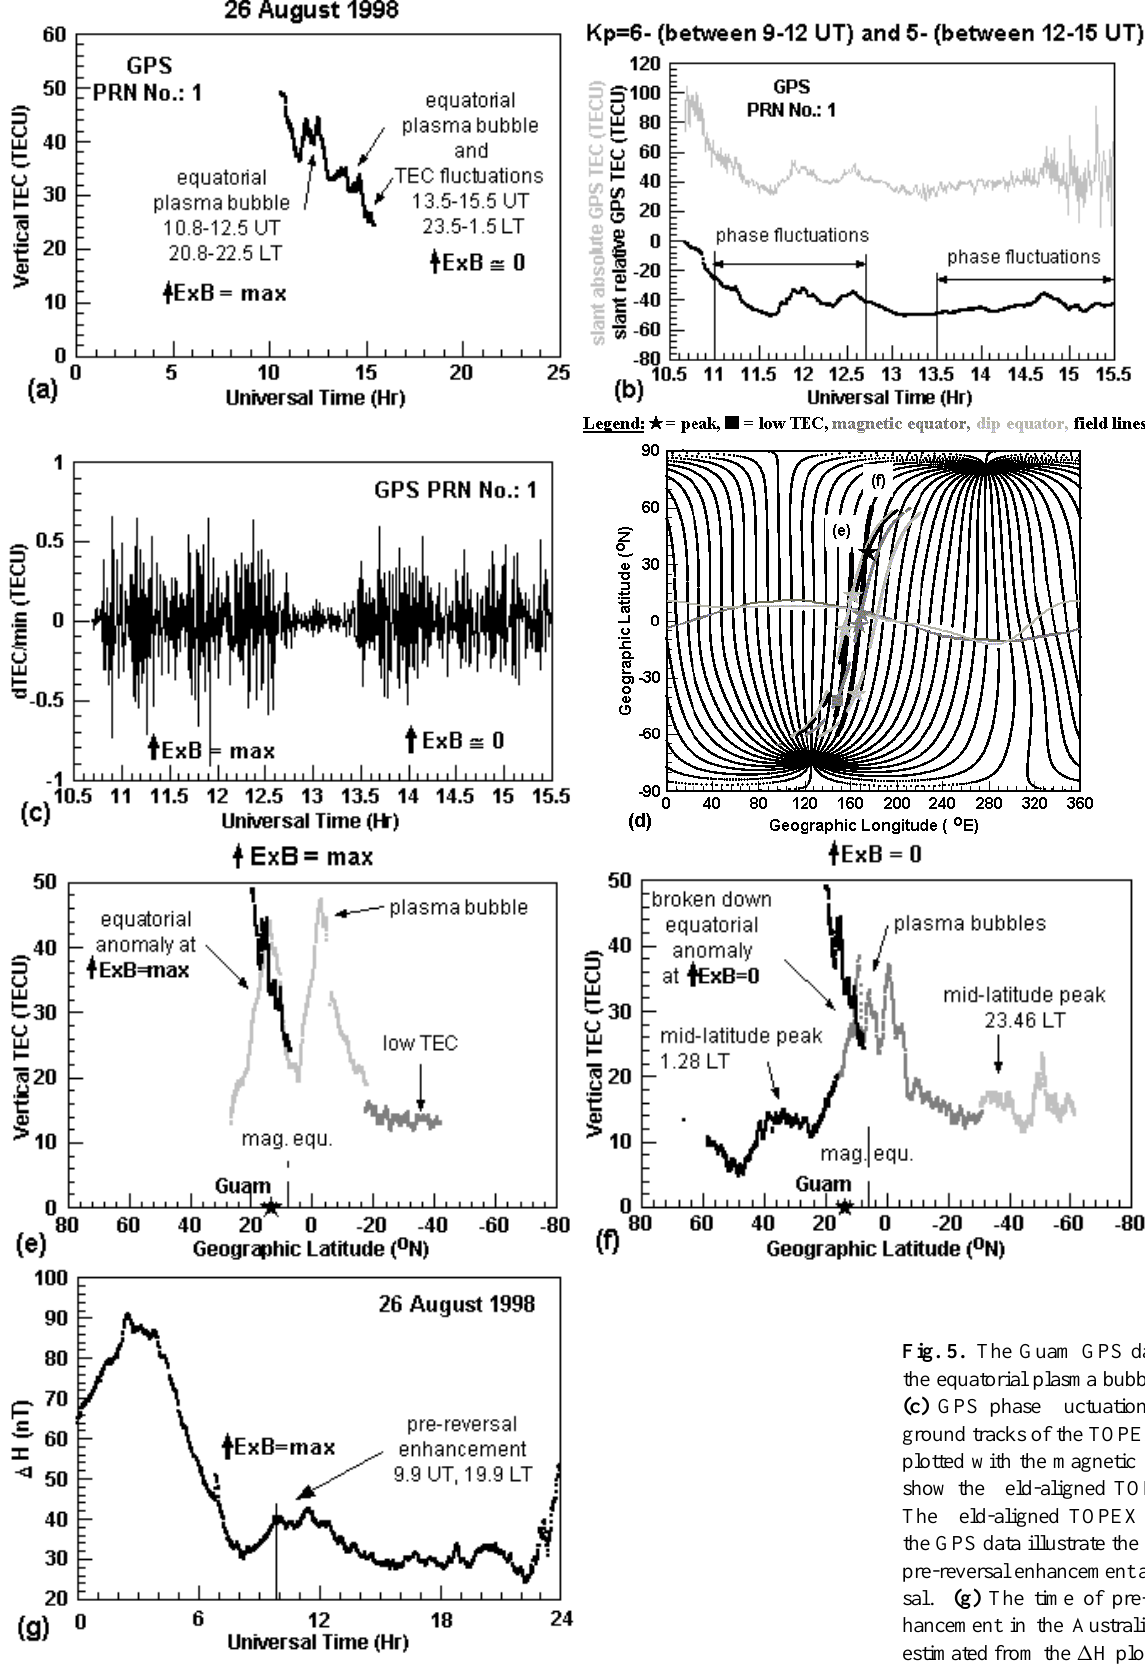
Fig. 5. The Guam GPS data show (a) the equatorial plasma bubbles and (b)– (c) GPS phase fluctuations. (d) The ground tracks of the TOPEX passes are plotted with the magnetic field lines to show the field-aligned TOPEX passes. The field-aligned TOPEX passes with the GPS data illustrate the events of (e) pre-reversal enhancement and (f) rever- sal. (g) The time of pre-reversal en- hancement in the Australian region is estimated from the 1 H